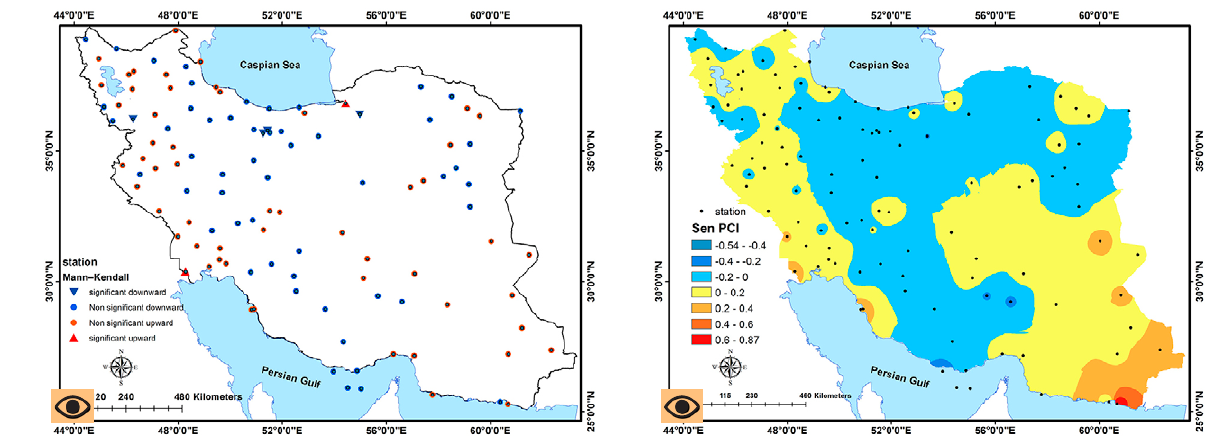
Figure 6. Results of the Mann–Kendall trend test across Iran over the period 1988-2017